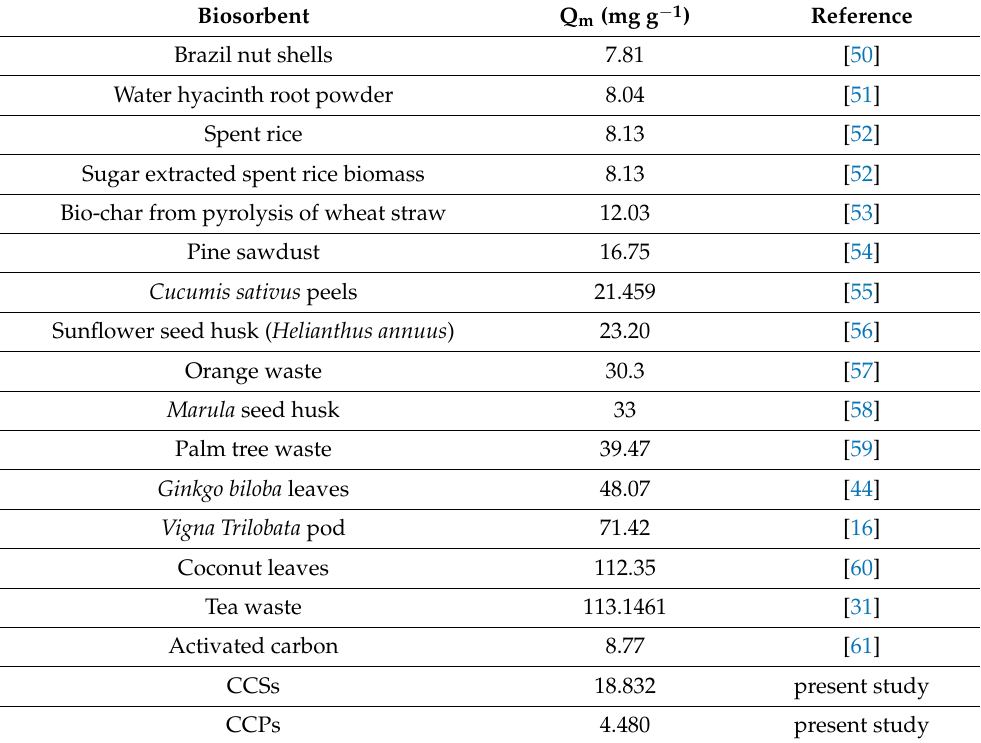
Table 5. Comparison of biosorption capacities of different biosorbents for MB dye elimination.